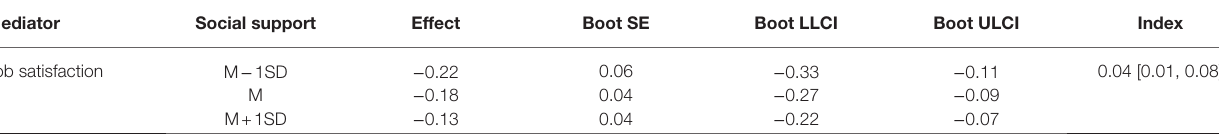
TABLE 7 | Bootstrap test of the moderated mediation effect.